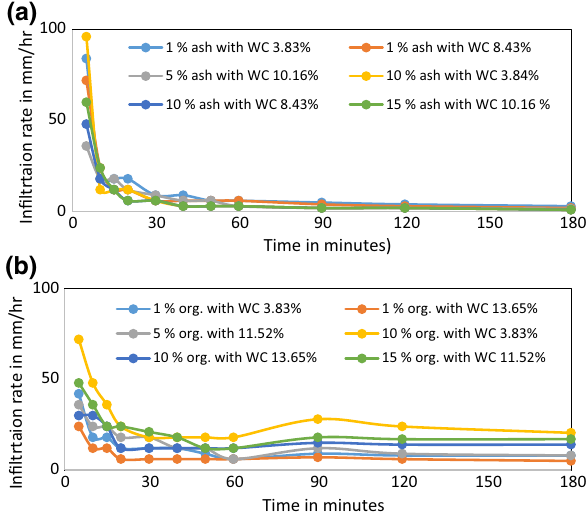
Fig. 2 Result analysis of the infiltration rate with different water qual- ities: a ash and b organic concentration of impurities (%) and moisture content (%) were the input variables, whereas infiltration rate (mm/h) was output. The features and correlation matrix of the data set are given in Tables 2 and 3.